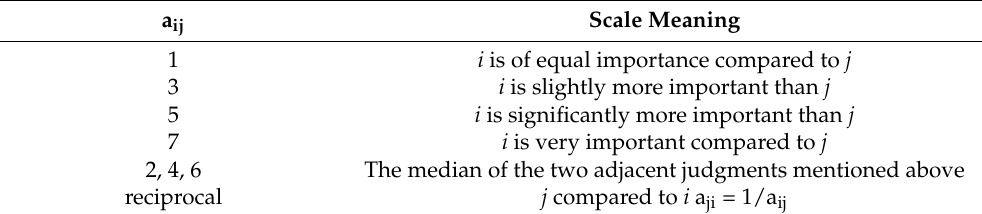
Figure 9. Auxiliary generator optimization hierarchy model.